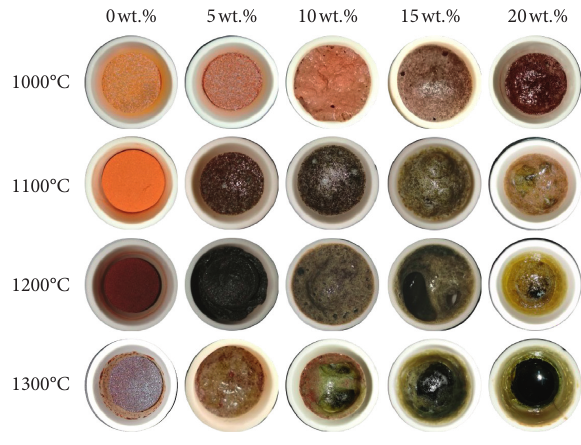
Figure 2: Samples